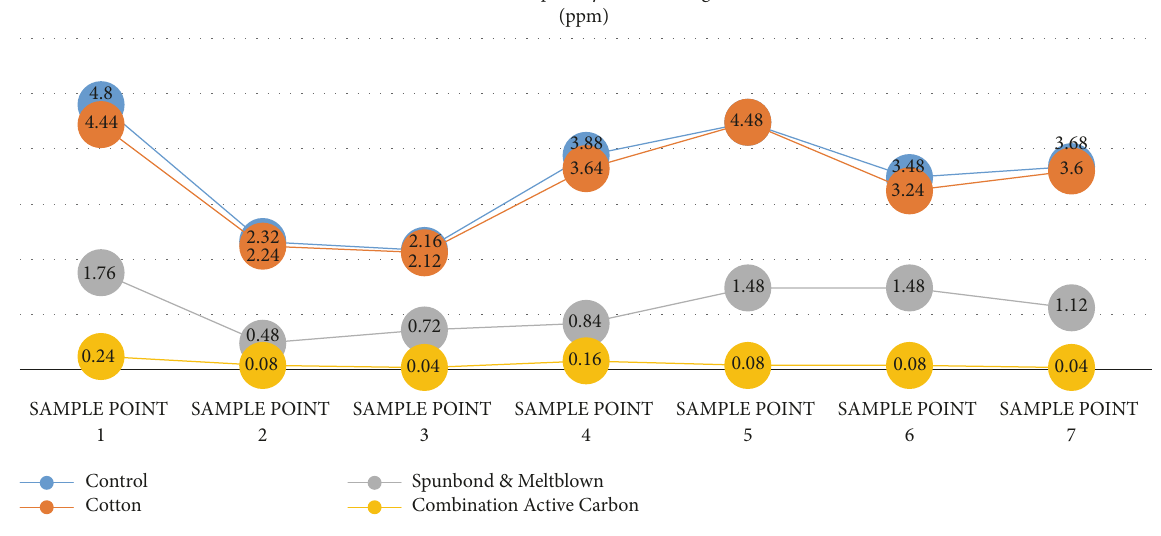
Figure 1: Various types of masks in absorbing